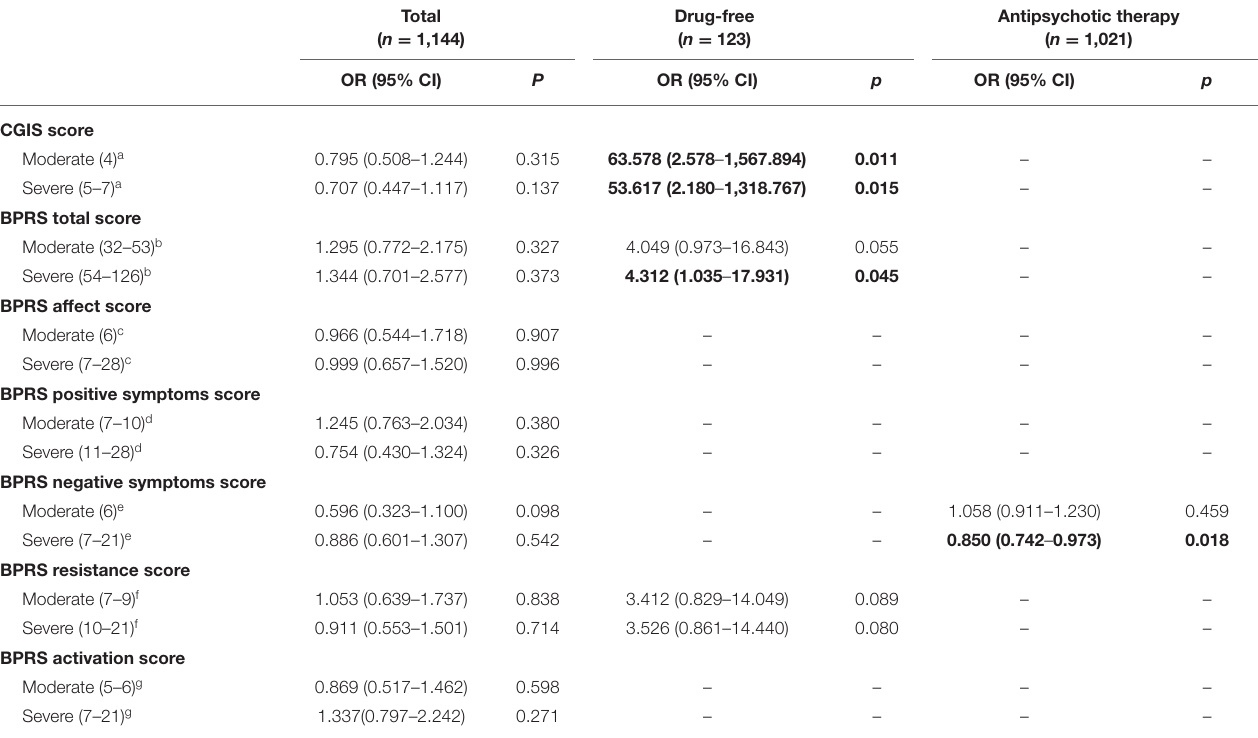
TABLE 3 | Logistic regression analyses of NLR associated with CGIS or BPRS scores after controlling for other